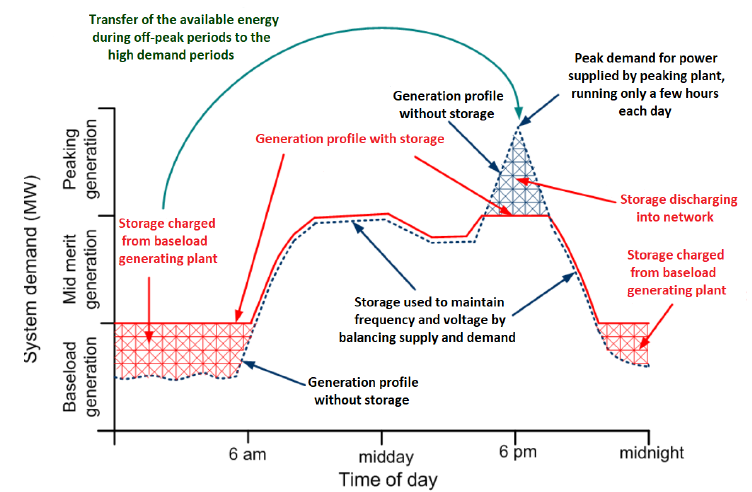
Figure 13. The function of ESS for power smoothing